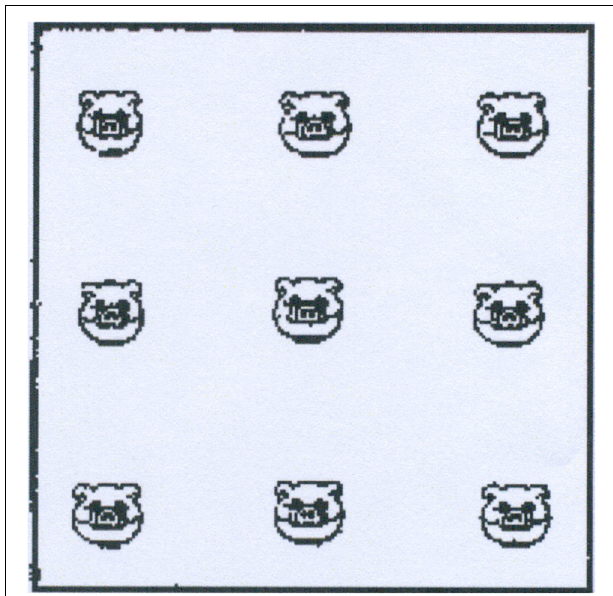
FIGURE 5 | The pigs in a pen problem.